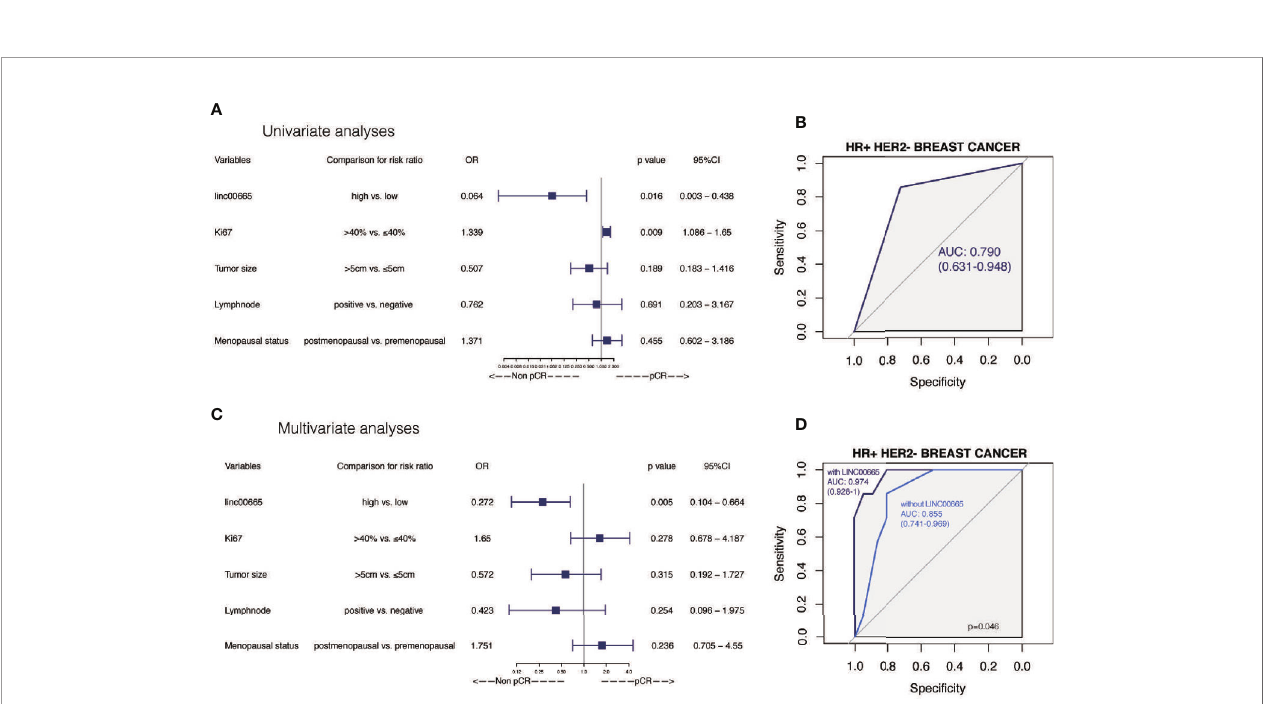
FIGURE 5 | The predictive value of Linc00665 expression in pCR in HR-positive/HER2-negative patients (A) Univariate logistic regression analysis of potential predictive markers in HR-positive/HER2-negative patients; (B) Performance of Linc00665 expression in predicting pCR evaluated by ROC in HR-positive/HER2- negative patients; (C) Multivariate logistic regression analysis of potential predictive markers in HR-positive/HER2-negative patients; (D) ROC of multivariate logistic regression including clinicopathological factors with or without Linc00665 expression in HR-positive/HER2-negative patients.